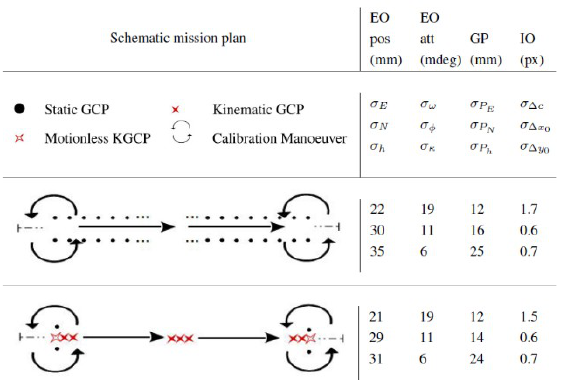
Figure 2: Results for simulated corridors, operated without KGCPs (up) and with KGCPs (down), as presented in (Molina et al., 2016)